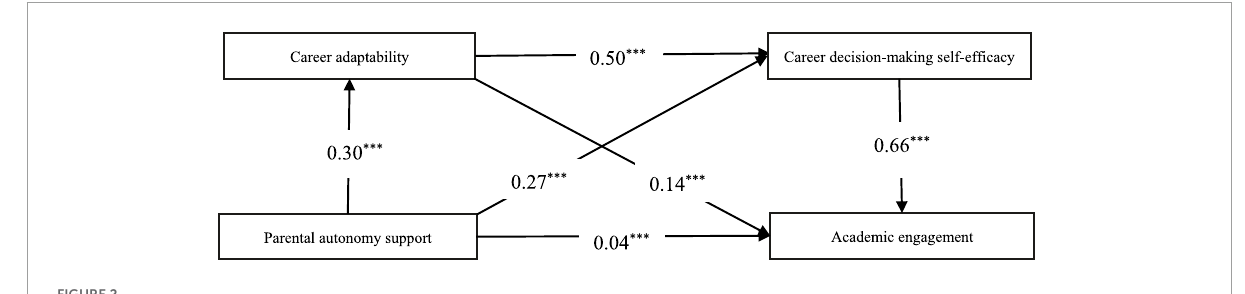
FIGURE2 Chain intermediary model. The *** indicates that the mediation effect path coefficient is significant at the 0.001